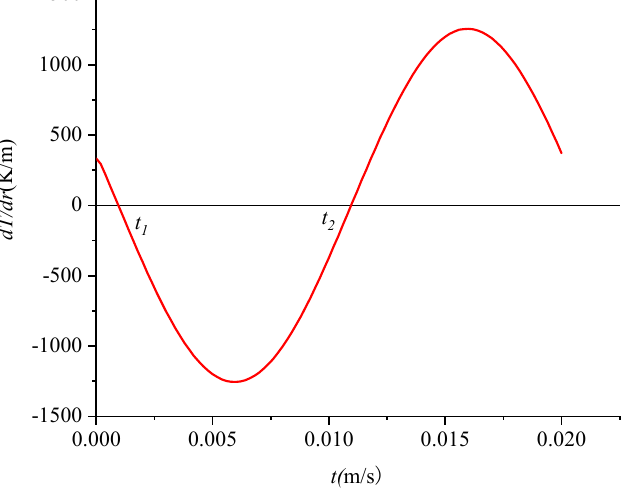
Figure 9. Temperature gradient curve.